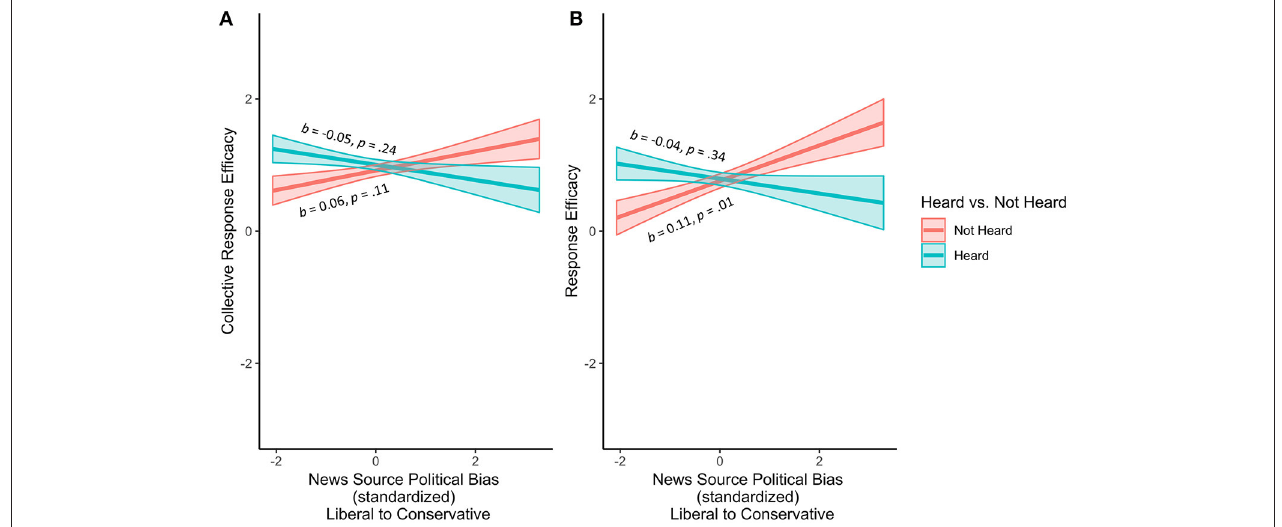
FIGURE 2 | Efficacy as a function of whether heard x news source. (A) F (1, 272) = 5.02, p = 0.03, 95% CI[ − 0.10, − 0.01], PRE = 0.02; Scale bands represent 95% confidence intervals. (B) F